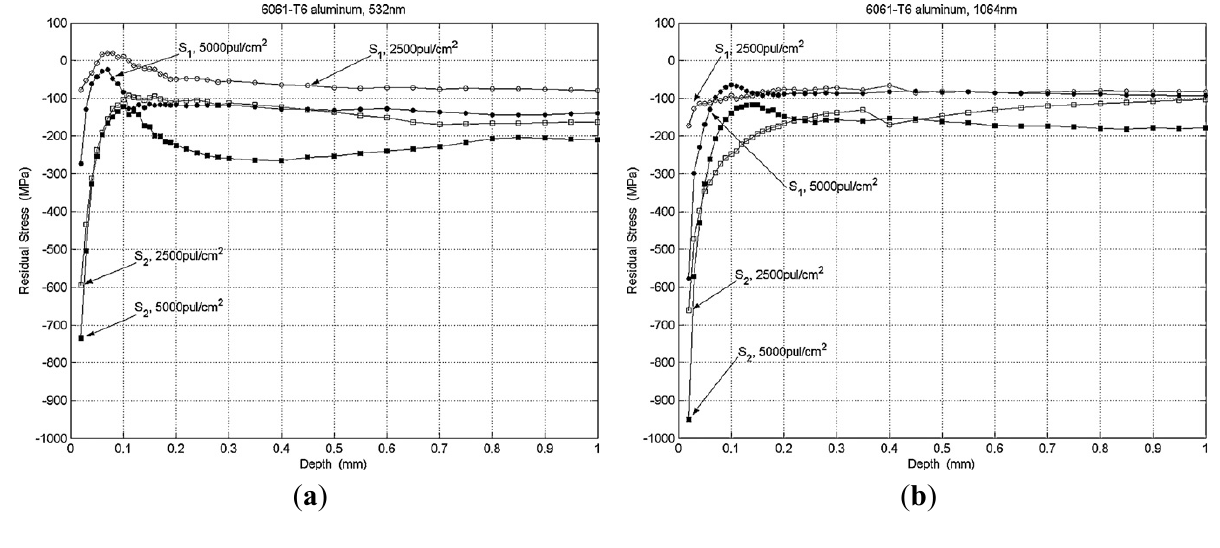
Figure 10. In-depth residual stress profile processed using ( a ) 532 nm and ( b ) 1064 nm wavelength [111].